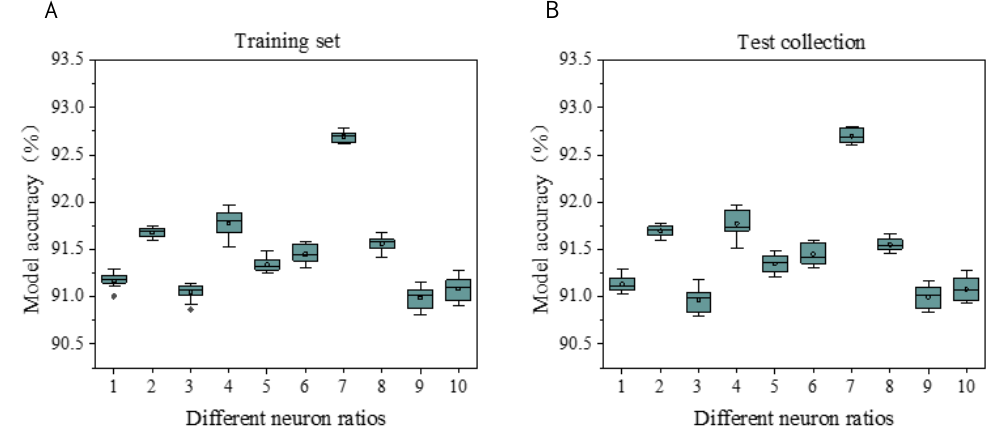
Figure 12. Model accuracy rate at di ff erent neuron ratios. Figure ( A ) shows the accuracy of the model under di ff erent neuron ratios on the training set; Figure ( B ) shows the accuracy of the model under di ff erent neuron ratios on the test set.